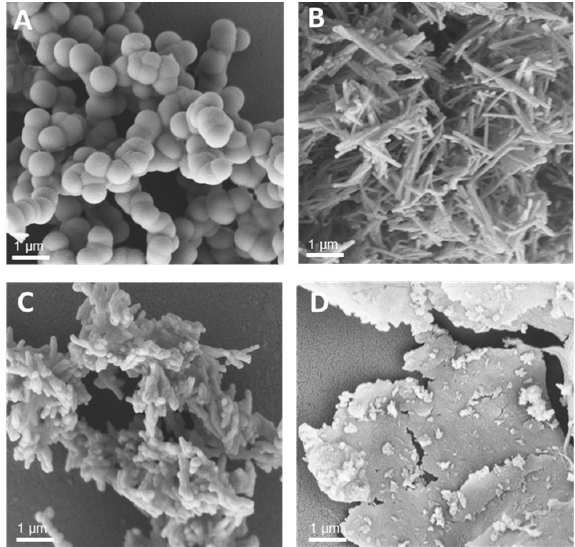
Figure 1. Scanning electron microscopy (SEM) images of silica particles generated from CysR5 1′ ( A ), RRIL-1 2′ ( B ), RRIL-2 3′ ( C ), and RRLL 4′ ( D ). Scale bar represents 1 µm. RRIL-1 2 (cid:48) ( B ), RRIL-2 3 (cid:48) ( C ), and RRLL 4 (cid:48) ( D ). Scale bar represents 1 µ